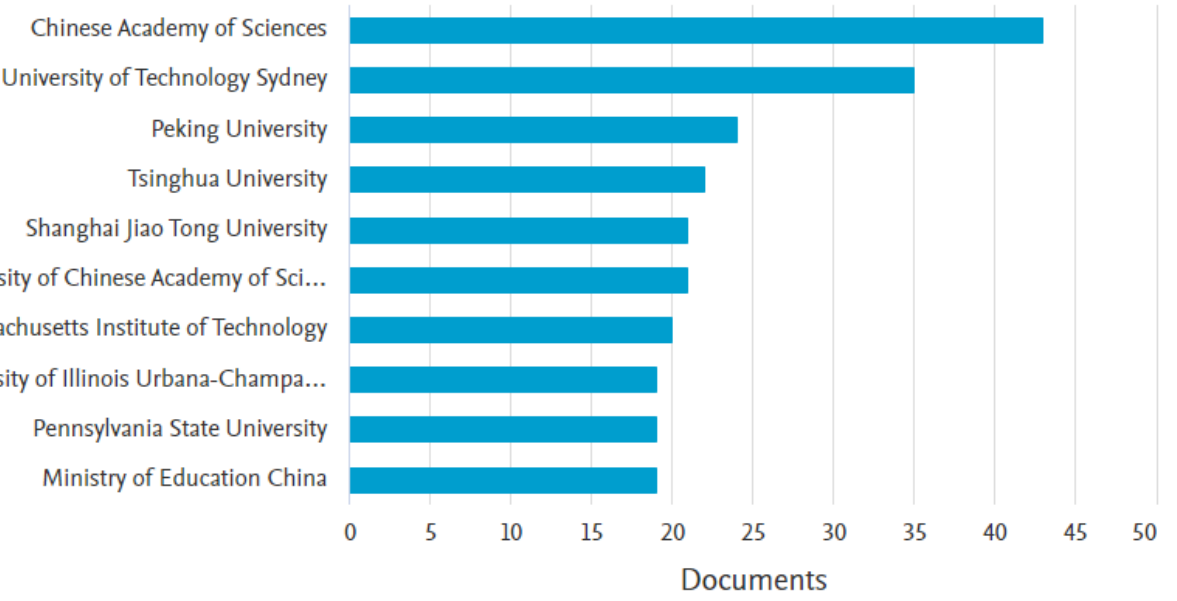
Figure 3. Documents by affiliations for “machine learning” AND “knowledge management” .